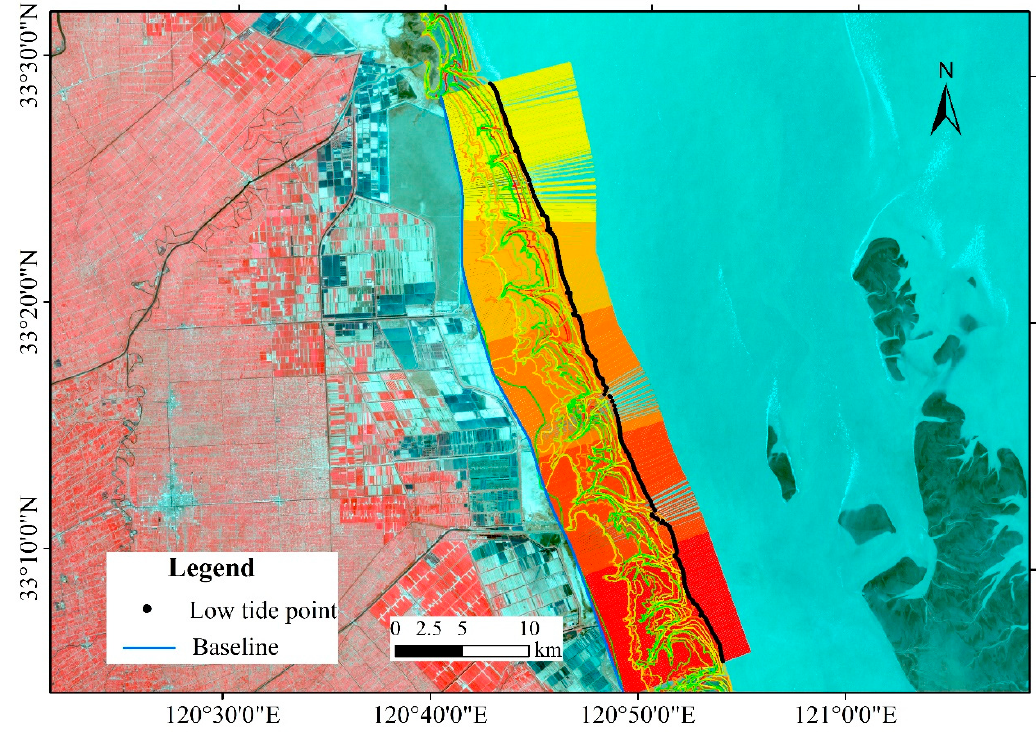
Figure 3. Determination of the tidal flat boundary.